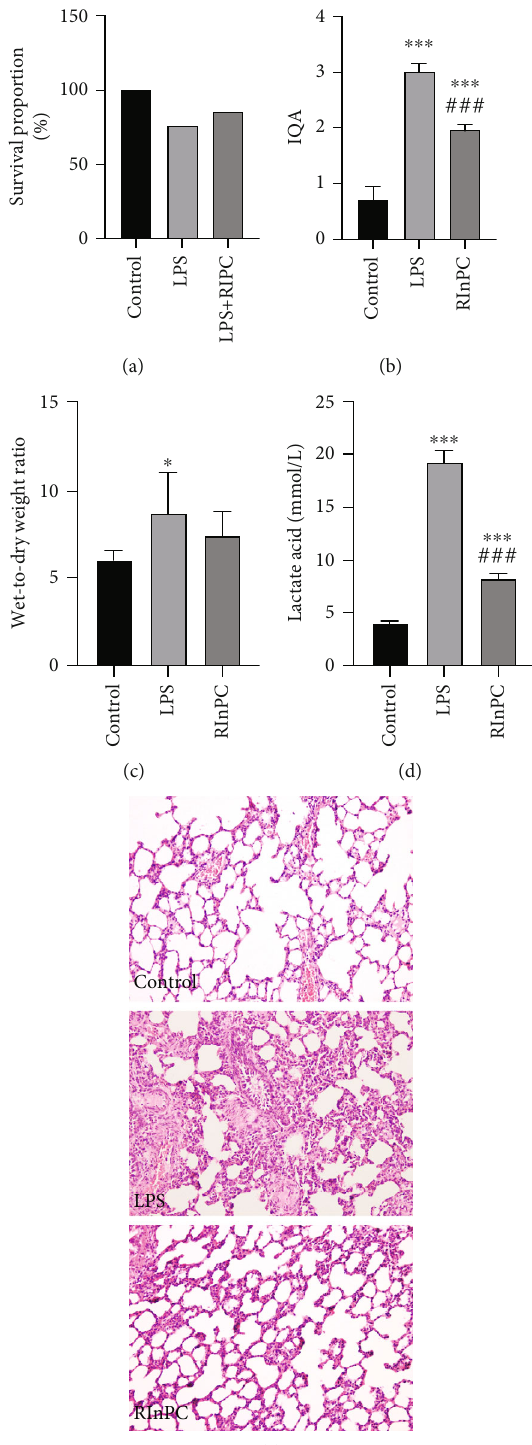
Figure 1: RInPC attenuated LPS-induced ALI in rats. (a) Comparison of survival proportion among three groups. (b) Comparison of ALI represented by IQA between each group. (c) Comparison of wet/dry ratio between each group. (d) Comparison of lactic acid in the serum of each group. (e) Histological changes of lung tissue in each group (H&E; 200x). Control: control group; LPS: LPS injury group; RInPC: LPS +RInPC group. In comparison, the LPS injury group showed di ff use edema in alveolar spaces and interstitium of the lung, hemorrhage, severe in fl ammatory cell in fi ltration and serous exudation in the alveolar space, and thickened interlobular septa. These changes were signi fi cantly mitigated in the RInPC group. ∗ P < 0 : 05 ; ∗∗ P < 0 : 01 ; ∗∗∗ P < 0 : 001 vs. control group; # P < 0 : 05 ; ## P < 0 : 01 ; ### P < 0 : 001 vs. LPS group ( n = 6 ); IQA: index of quantitative